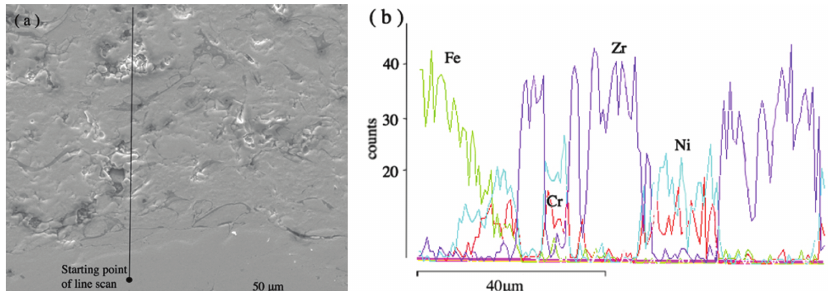
Figure 3: (a) Cross-sectional morpholo- gies of OQ-MC, (b) EDS line scan profile of